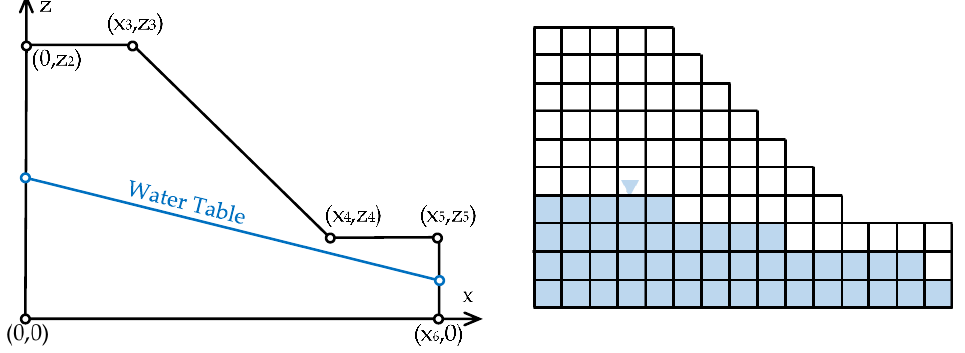
Figure 9. ( a ) The required nodes to define slope geometry; ( b ) the discretized domain in the finite di ff erence method